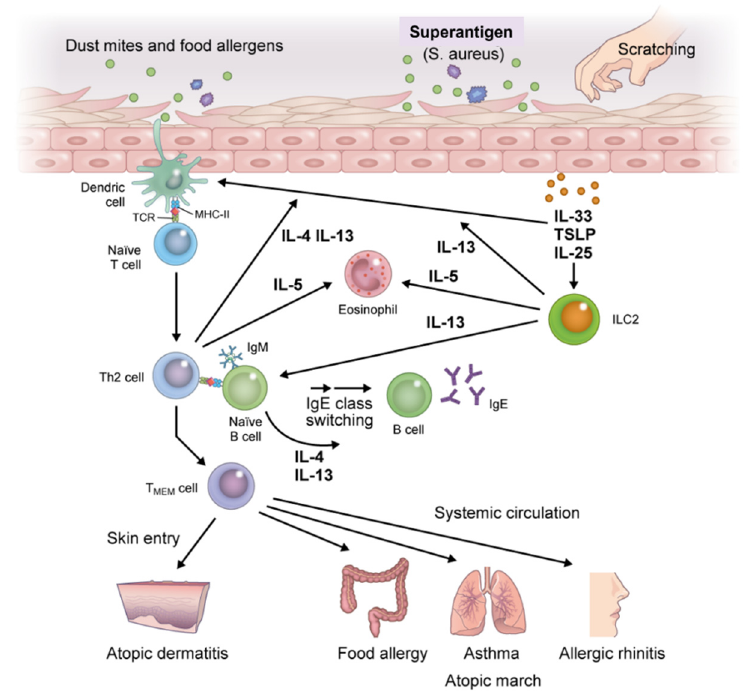
Figure 3. Immunologic mechanisms underlying atopic march. Exposure of skin with impaired barrier function to food allergens, dust mites, or mechanical damage leads to the release of epithelial cell-derived thymic stromal lymphopoietin (TSLP), interleukin (IL)-25, and IL-33, which induce the activation of immature dendritic cells (DCs) and group 2 innate lymphoid cells (ILC2s). DCs that capture allergens migrate to draining lymph nodes, process allergens, and present them to naïve